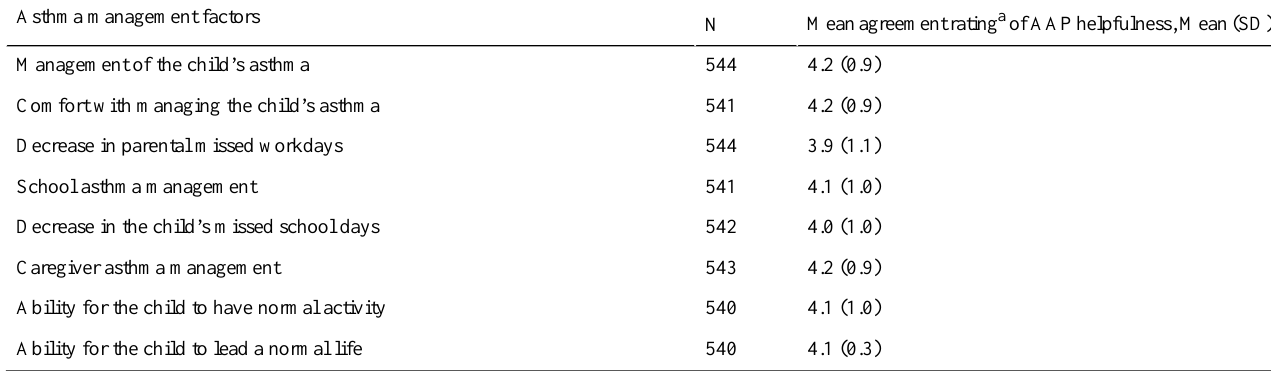
Table 2. Participant ratings of the helpfulness of Asthma Action Plans (AAPs).